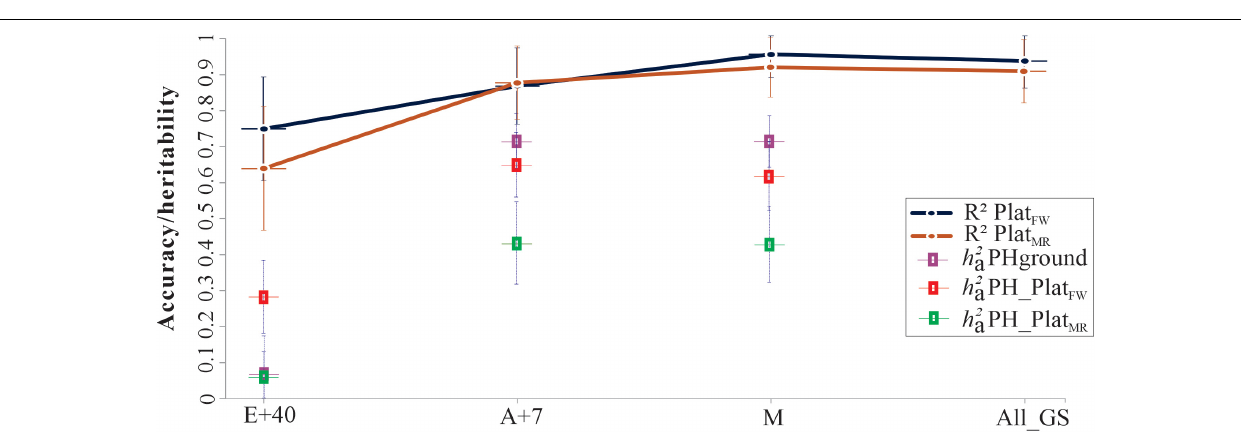
FIGURE 8 | Narrow-sense heritability ( h 2 a ) and coefficient of determination ( R 2 ) from genotype-by-environment interaction (G × E) model using HiBAP-I genotypes measured in 2016–2017 and 2017–2018 growing cycles via Plat FW and Plat MR , and across growth stages (GS): 40 days after emergence (E+40), 7 days after flowering (A+7), and at physiological maturity (M). The solid color lines represent the accuracy ( R 2 ) for predict values between PHground and PHaerial, plus the confidence interval (CI) by the error bar. The colored squared represents the h 2 a and the error bars indicate standard error. All growth stages (All_GS) were also considered to confirm the accuracy of genetic correlations. The cross lines give the upper and lower bounds of the 95% CI of the correlations computed using ρ = 1 . 96 p ( 1 − ρ )/( n − 2 ) , where ρ is the estimated correlation, and n is the number of records used to compute the b b b